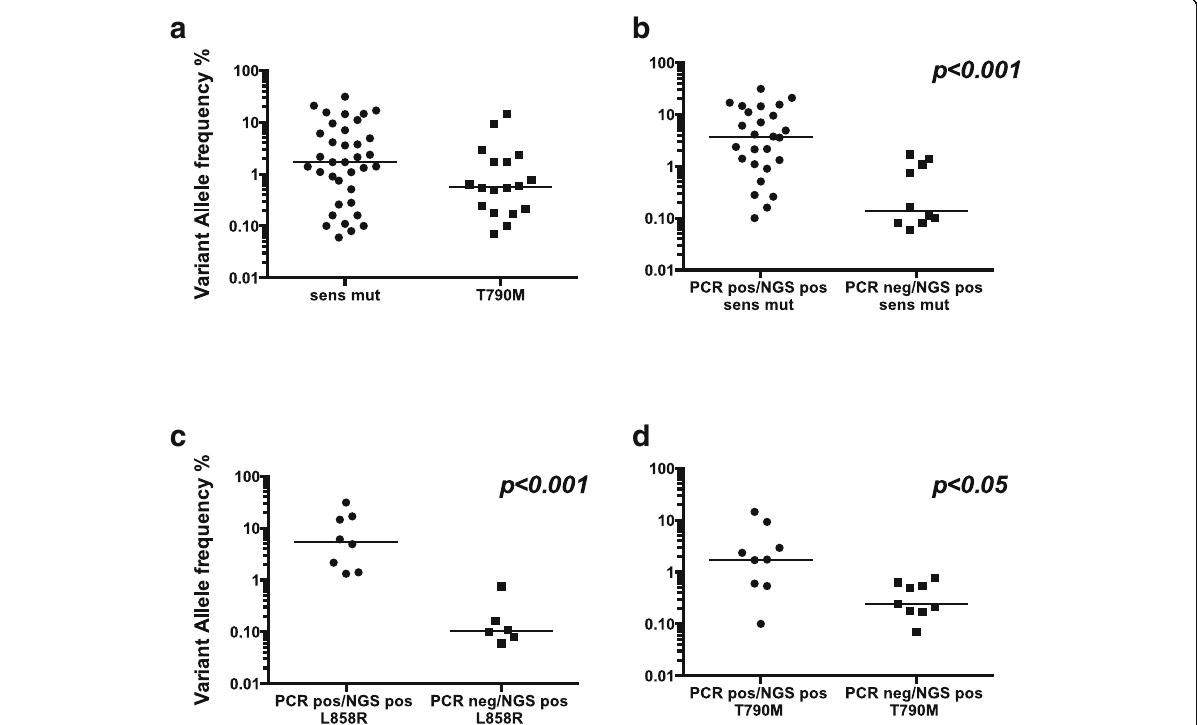
Fig. 2 Variant allele frequency (%) in plasma. Sensitizing EGFR mutations ( n = 36 cases) and T790M mutations ( n = 18 cases) were determined in plasma by tag-based NGS and are reported as variant allele frequency percentage (%) ( a ) Variant allele frequency (%) for EGFR mutations determined by tag-based NGS in two patients groups classified as positive or negative for the sensitizing mutation of EGFR based on both (black circles) or one (black squares) the methods employed in the study ( b ) Results of tests similar to those in b except that the L858R and T790M mutations were measured in ( c ) and ( d ), respectively. Each dot represents one patient. Solid lines represent median values. Statistical P values were derived from a Mann-Whitney test. PCR, Real Time PCR; NGS, tag-based NGS; sens mut, sensitizing mutations; pos, positive; neg,